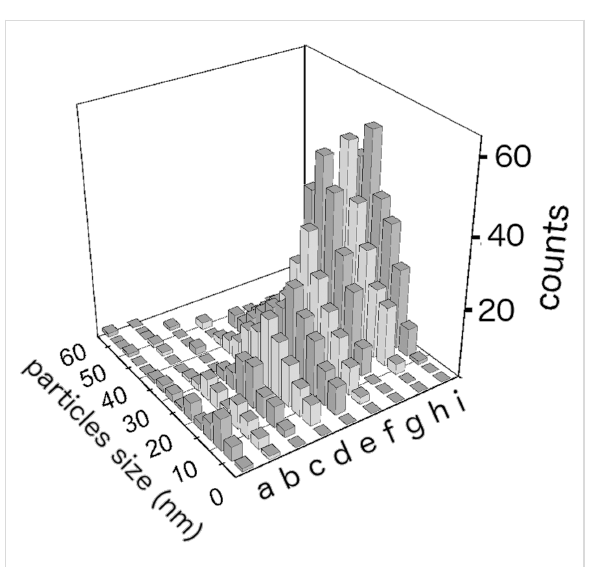
Figure 4: Size distribution of silver nanoparticles obtained from sam- ples containing different NH 3 concentrations: (a) without ammonia and (b–i) with 0.01, 0.1, 1, 5, 10, 100, 1000 and 2000 ppm ammonia.